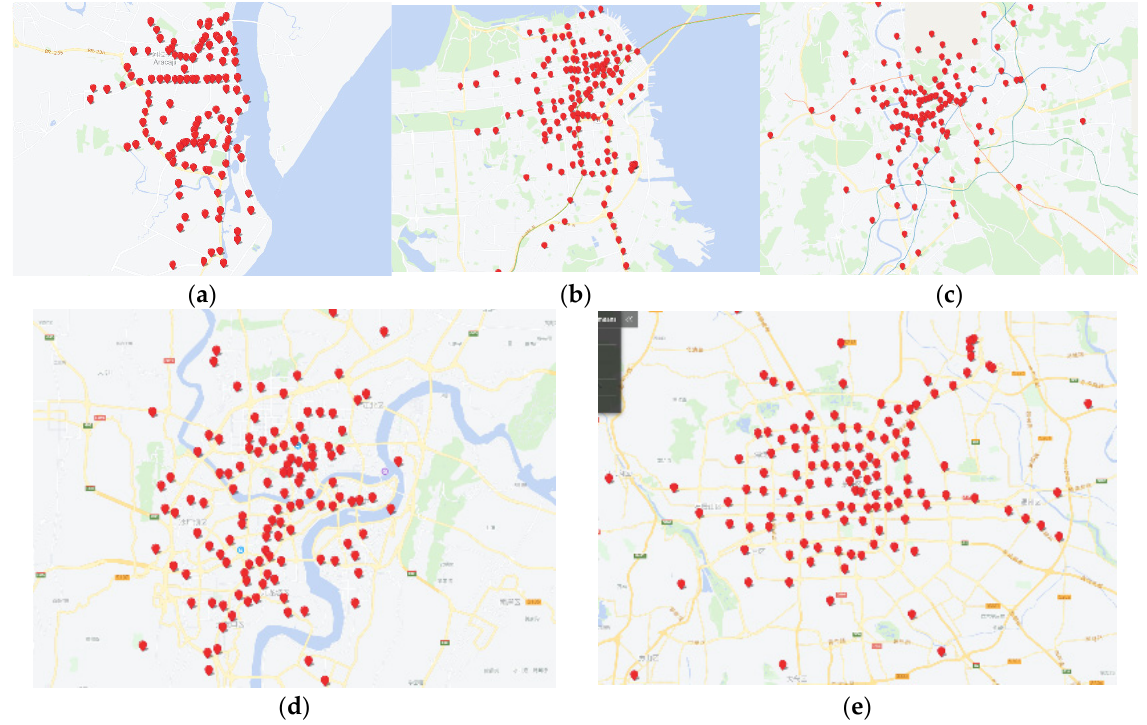
Figure 9. The city hotspot markers for the city taxi GPS data found by the FCM method: ( a ) Aracaju (Brazil), ( b ) San Francisco (USA), ( c ) Rome (Italy), ( d ) Chongqing (China), ( e ) Beijing (China).